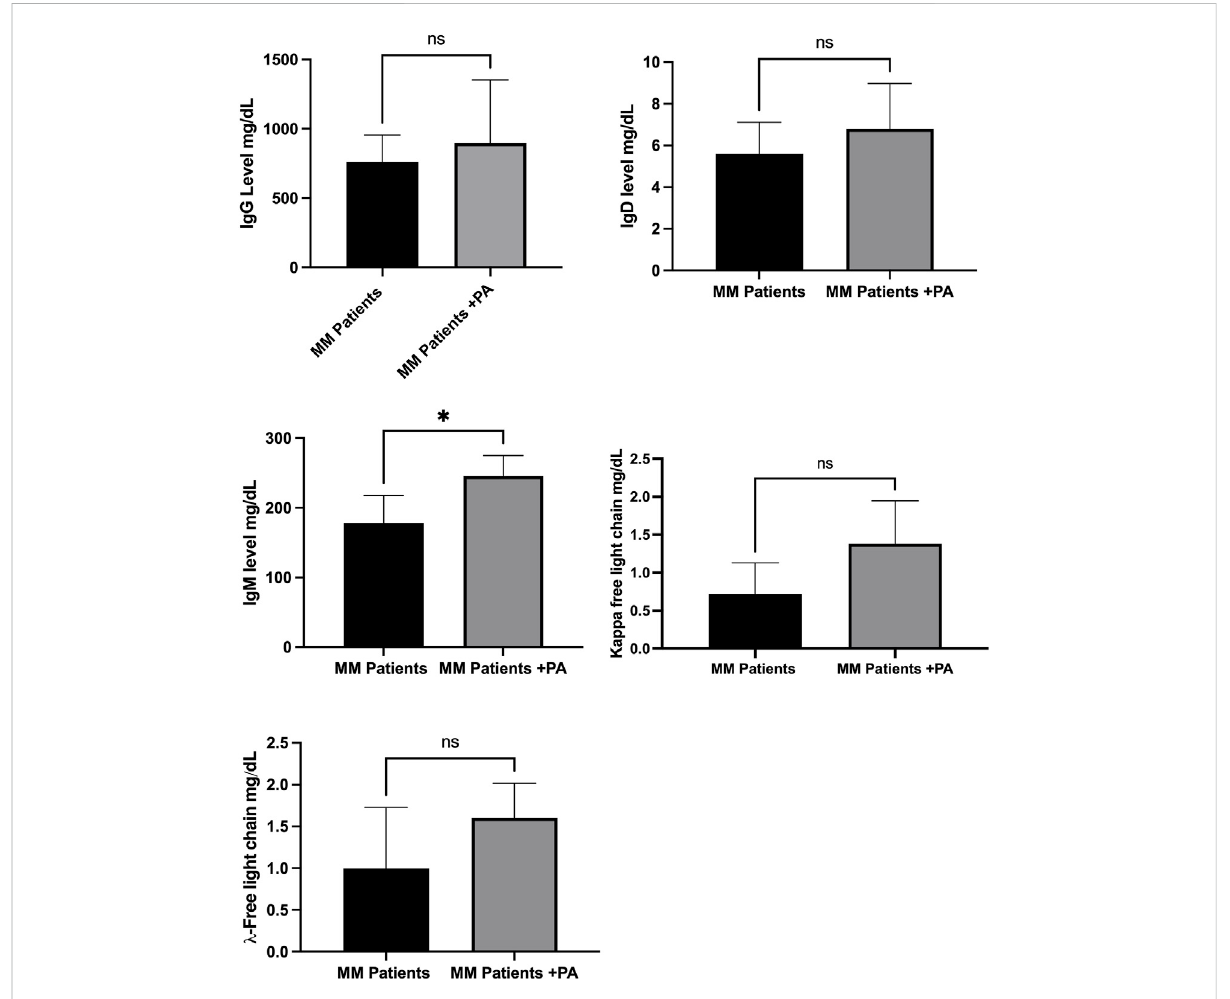
FIGURE 3 Effects of physical activity with MM patients on